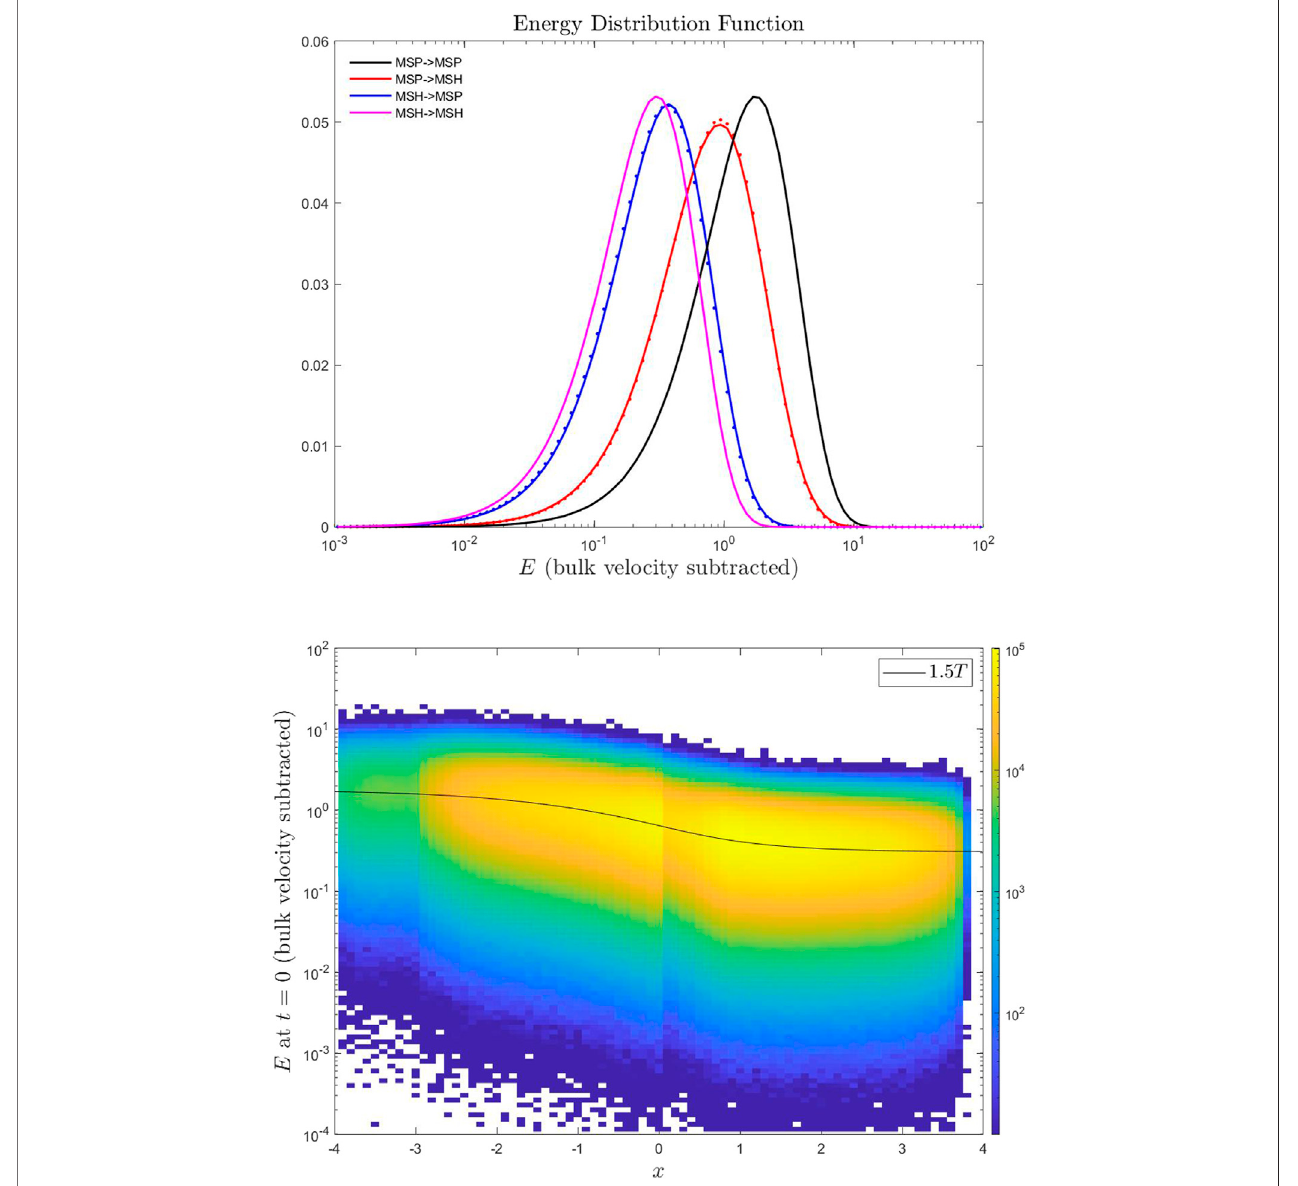
FIGURE3| Thetoppanelshowstheenergydistribution(seetext)forfourdifferenttypesofparticles(seelegend)fromthesymmetriccase.Thesolidlinesrepresent those particles ’ energy distribution at t (cid:1) 130, while the dotted lines represent those particles ’ energy distribution at t (cid:1) 0. The bottom panel shows the initial energy distribution as a function of their initial location ( x -component) for the particles crossing between the magnetosphere and the magnetosheath. The black line shows the energy-associated with initial temperature 1.5 T .